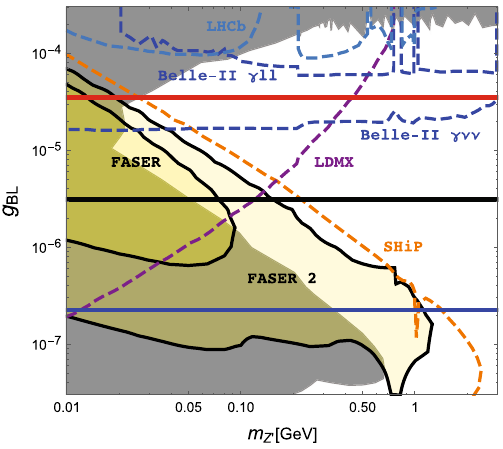
Fig. 2 Gauge coupling values as a function of m Z (cid:2) (cid:9) m to repro- duce the observed DM relic density in the standard Big Bang (horizon- tal black line), RS (horizontal red line) and GB (horizontal blue line) cosmologies, along with the search reach of various planned/proposed experiments at the Lifetime Frontier and the current excluded region (gray shaded). We have fixed x t = 100 ( x t = 10 6 ) for the RS (GB) cosmology. the gauge couplings are found to be g BL = 3 . 50 × 10 − 5 , 3 . 11 × 10 − 6 and 2 . 27 × 10 − 7 for the RS, standard Big Bang and GB cosmologies,